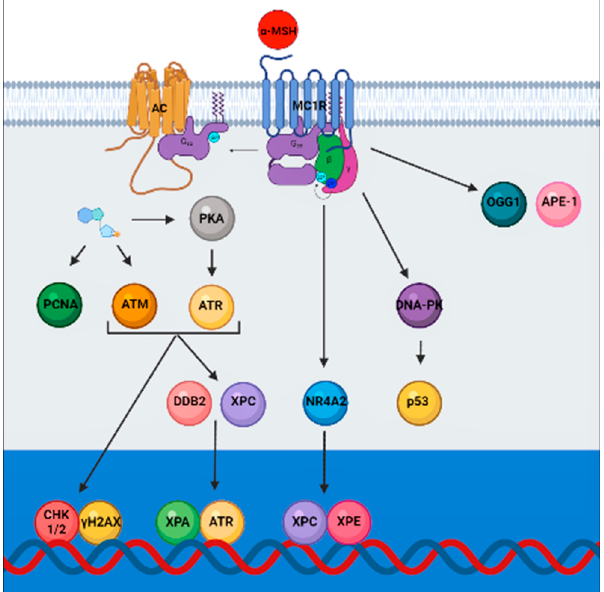
Figure 2. MC1R signaling promotes genomic stability through NER and BER. MC1R activation induces translocation of NR4A2 to the nucleus where it co-localizes with XPC and XPE at the sites of UV-induced DNA damage. MC1R activation also leads to elevated levels of XPC and γ H2AX, promoting the formation of DNA repair-complexes. Levels of γ H2AX are regulated downstream of ATR and by DNA-PK mediated phosphorylation of p53. In addition, PKA activation promotes the phosphorylation of ATR and ATR complexes with XPA in the nucleus. Following phosphorylation of XPA, the complex translocates to the sites of UV-induced DNA damage. α -MSH also enhances the expression of OGG1 and APE-1. The cumulative effects is maintenance of genomic stability of melanocytes by activation of nucleotide excision and base excision repair pathways (NER and BER). This figure was created with BioRender.com.